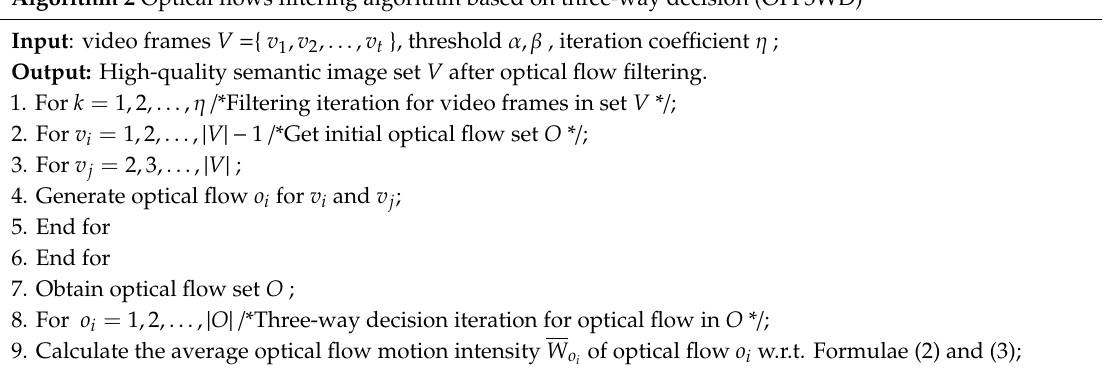
Algorithm 2 Optical flows filtering algorithm based on three-way decision